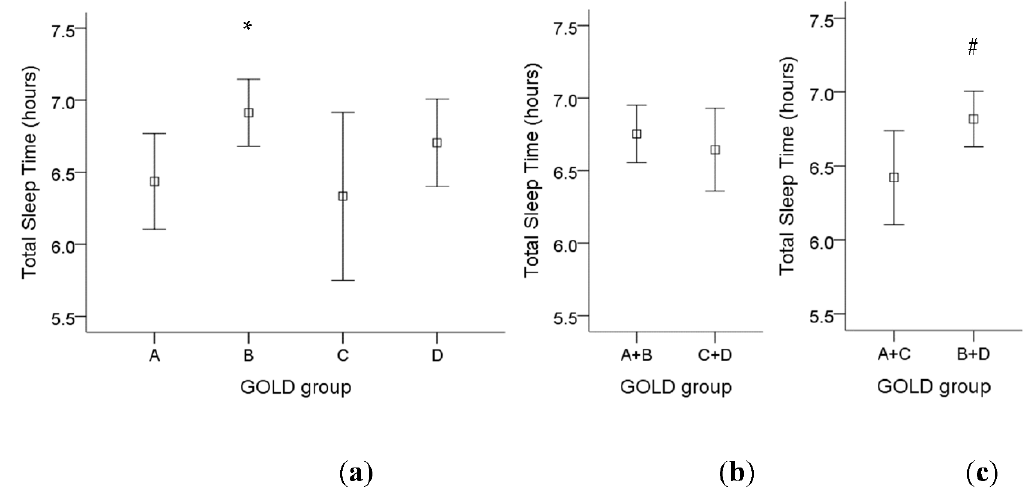
Figure 2. The influence of different GOLD groups on total sleep time in COPD patients. ( a ) There was a significant increase in total sleep time in GOLD group B compared to GOLD group A. ( b ) There was no significant difference in total sleep time among low-risk patients (group A and B) compared to high-risk patients (group C and D). ( c ) There was a significant higher total sleep time in COPD patients with more symptoms (group B and D) compared to fewer symptoms (group A and C). Note: 95% confidence interval, *: p < 0.05 vs. Group A; #: p < 0.05 vs. Group A + C. Abbreviations: GOLD = Global Initiative for Chronic Obstructive Lung Disease.